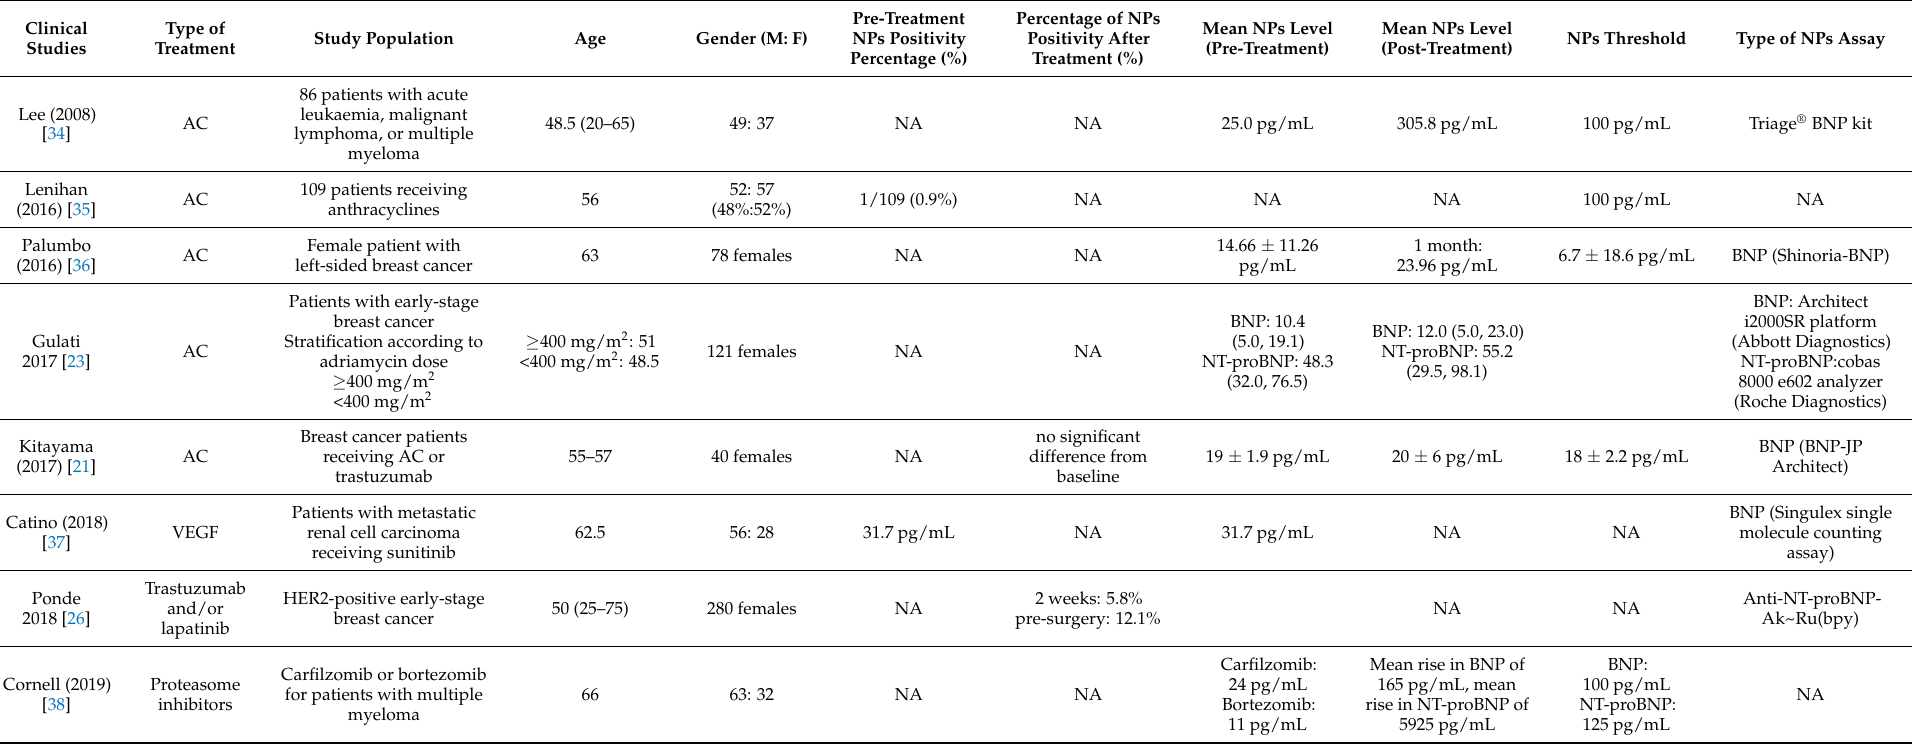
Table 3. NPs are a predictor of CTRCD due to anti-cancer